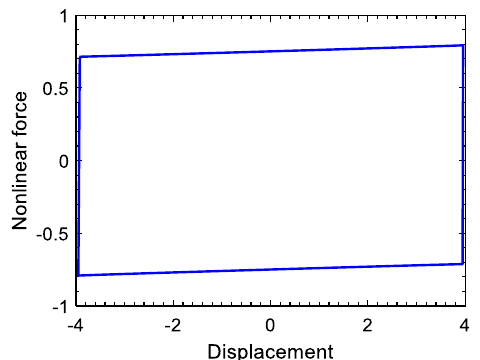
Figure 10. Nonlinear force vs. displacement difference.